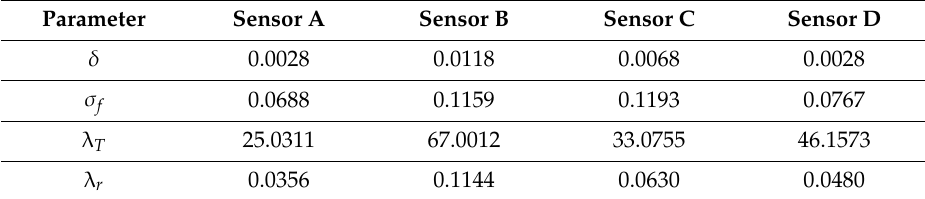
Table 4. Gaussian process regression (GPR) model